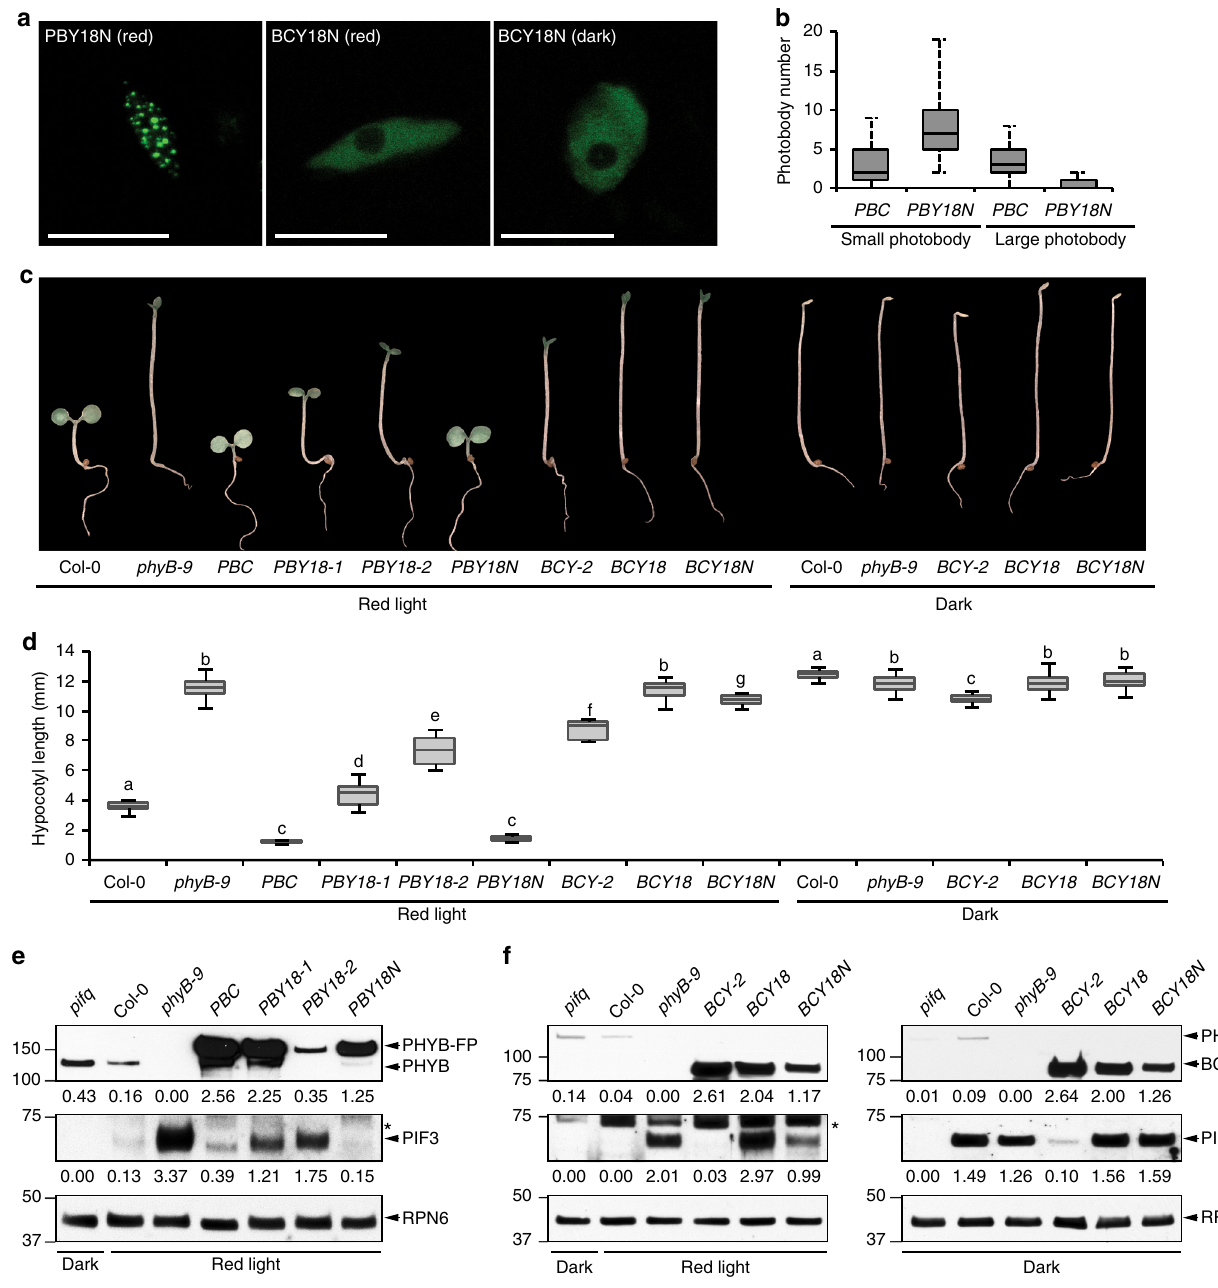
Fig. 4 Fusing an NLS largely rescues the function of full-length but not the C-terminal module of PHYB18. a Confocal images showing the subnuclear localization patterns of PBY18N in 10 μ mol m − 2 s − 1 R light and BCY18N in red light and darkness. b Box and whisker plots showing the number of small ( < 1 μ m 3 ) and large ( ≥ 1 μ m 3 ) photobodies in hypocotyl epidermal cells of PBC and PBY18N seedlings grown under 10 μ mol m − 2 s − 1 R light. c Images of representative 4-day-old seedlings of the indicated lines grown under 10 μ mol m − 2 s − 1 R light or in the dark. d Box and whisker plots of hypocotyl measurements of seedlings shown in c . The boxes represent from 25th to 75th percentile; the bars equal to the median values. Samples with different letters exhibit statistically signi fi cant differences in hypocotyl length (ANOVA, Tukey ’ s HSD, P < 0.01, n > 40). e Immunoblots showing the levels of PHYB and PIF3 in 4-day-old Col-0, phyB-9 , PBC , PBY18-1 , PBY18-2 , and PBY18N seedlings grown in 10 μ mol m − 2 s − 1 R light. The sample of dark-grown pifq was used as a negative control for the PIF3 Immunoblots. RPN6 was used as a loading control. The relative levels of PHYB, PHYB-FP, and PIF3 were normalized against the corresponding levels of RPN6 and are shown below the blots. The asterisks in the PIF3 blots indicate nonspeci fi c bands. f Immunoblots showing the levels of PHYB and PIF3 in 4-day-old Col-0, phyB-9 , BCY-2 , BCY18 , and BCY18N grown either in 10 μ mol m − 2 s − 1 R light or darkness. Dark-grown pifq samples were used as negative controls for the PIF3 immunoblots. RPN6 was used as a loading control. The relative levels of PHYB and PIF3 were normalized against the corresponding levels of RPN6 and are shown below each